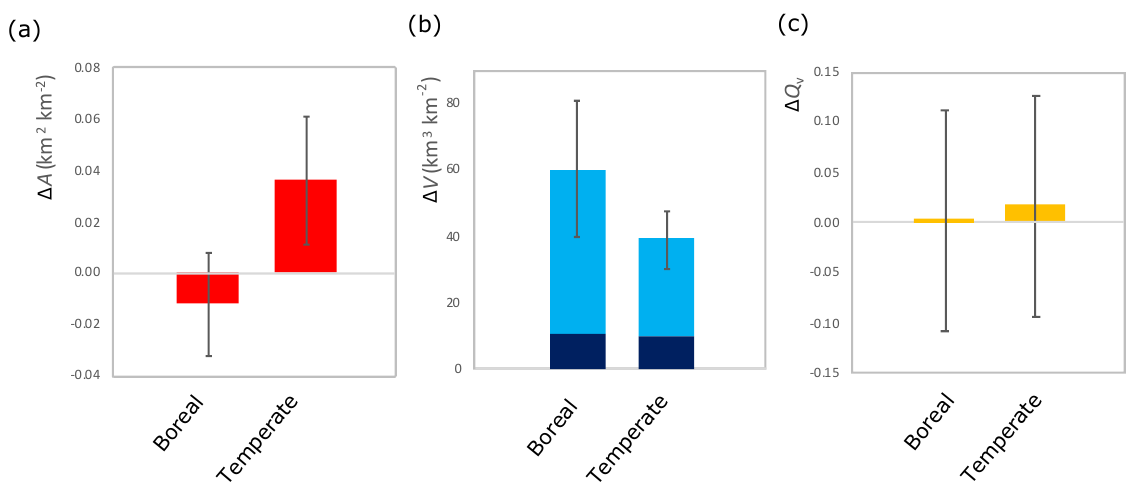
Figure 7. Changes in forest attributes per biome. Changes in both basin groups between the comparative 26-year periods 1961–1986 and 1987–2012, in (a) forest cover ( (cid:49)A) , (b) standing forest volume ( (cid:49)V ) and (c) forest composition represented as the ratio of the stand- ing deciduous-forest volume to total standing forest volume ( (cid:49)Q v ). The whiskers represent the uncertainty range of (cid:49)A , (cid:49)V and (cid:49)Q v corresponding to the sampling standard errors for A (2.7%), V (5%) and propagated Q v (10%). For (b) , the dark blue represents (cid:49)V of deciduous trees and light blue of coniferous